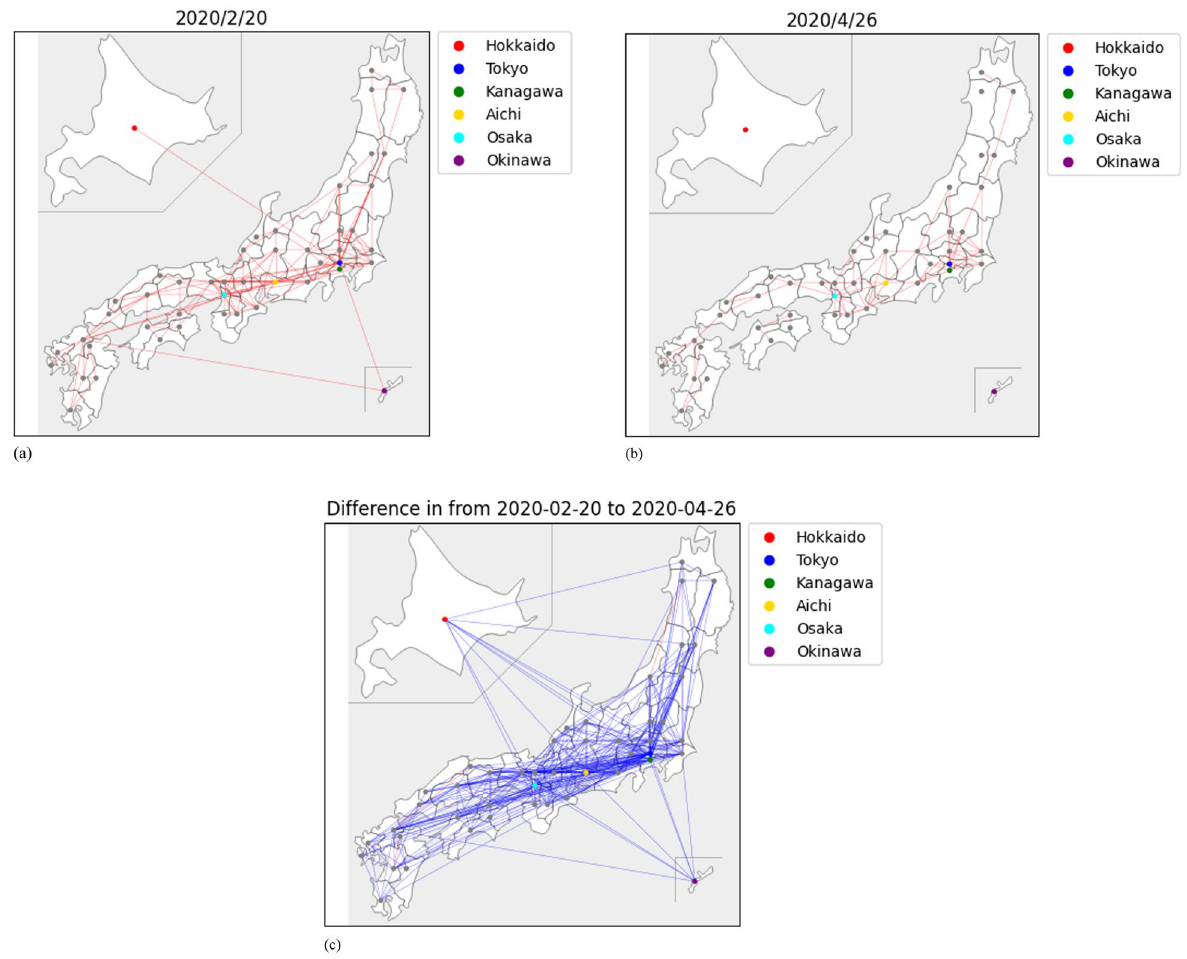
Figure 2. Networks of inter prefecture human mobility in Japan (Hokkaido: top left, Okinawa: bottom right) LocationMind xPop © LocationMind Inc. All analyses were conducted using R (version 4.1.0) and Python